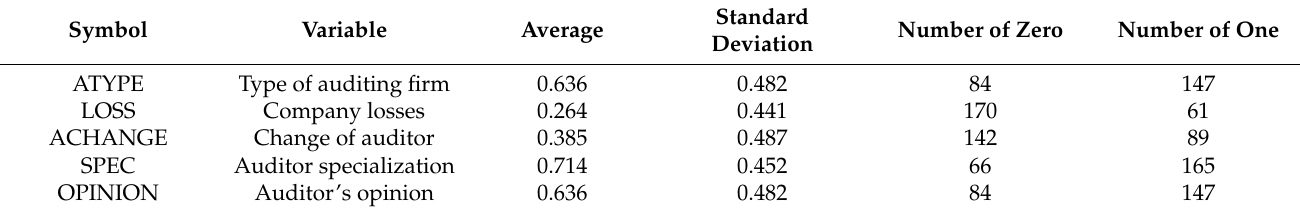
Table 3. The descriptive statistics of dummy